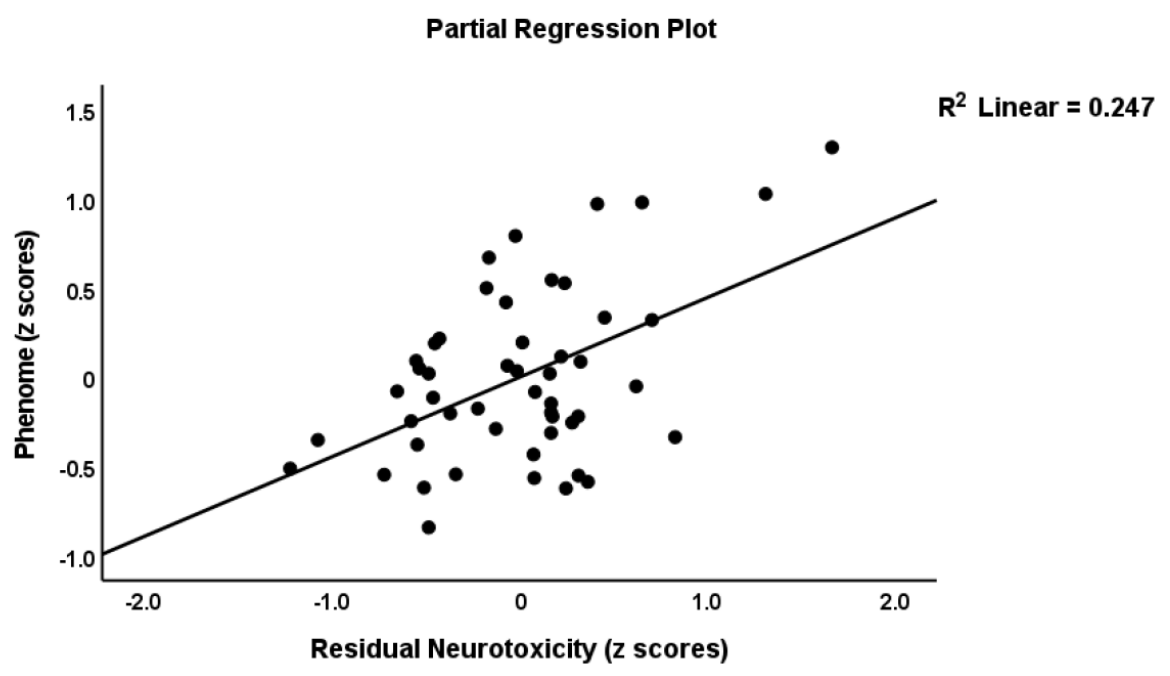
Figure 2. Partial regression of the phenome score on the immune-neurotoxicity index.